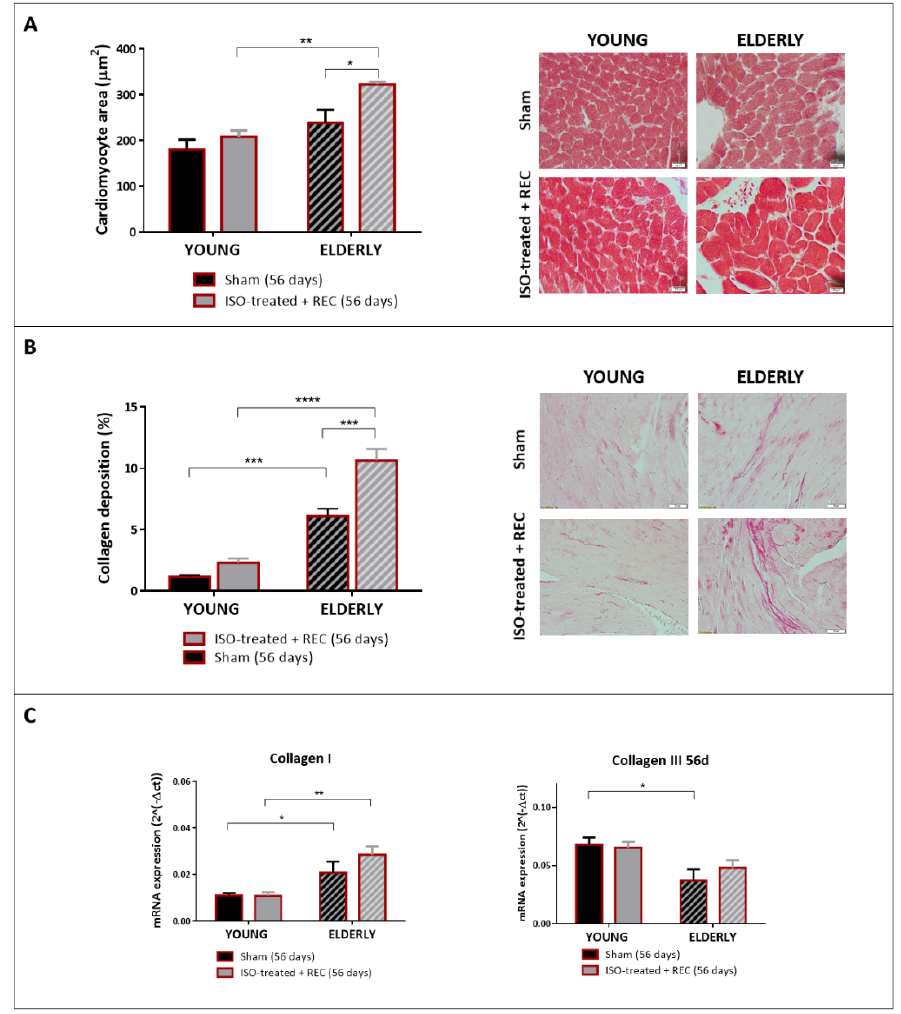
Figure 4. Histological findings and mRNA expression analyses at 56 days, after exposure to isoproterenol or saline infusion and recovery, in young and elderly mice. ( A ) Cardiomyocyte cross-sectional area (CSA) in the four study groups. A representative microphotograph for each one of them is shown (magnification ×40). N = 5/5 in sham/ISO-treated young mice; N = 3/4 in sham/ISO-treated elderly mice. ( B ) Quantification of collagen deposition in picrosirius-stained sections in the four study groups. Representative microphotographs are shown (magnification ×20). ( C ) mRNA expression of collagen I and collagen III in the four study groups. N = 6/7 in sham/ISO-treated young mice; N = 3/4 in sham/ISO-treated elderly mice. * p < 0.05, ** p < 0.01, *** p < 0.001, **** p < 0.0001.